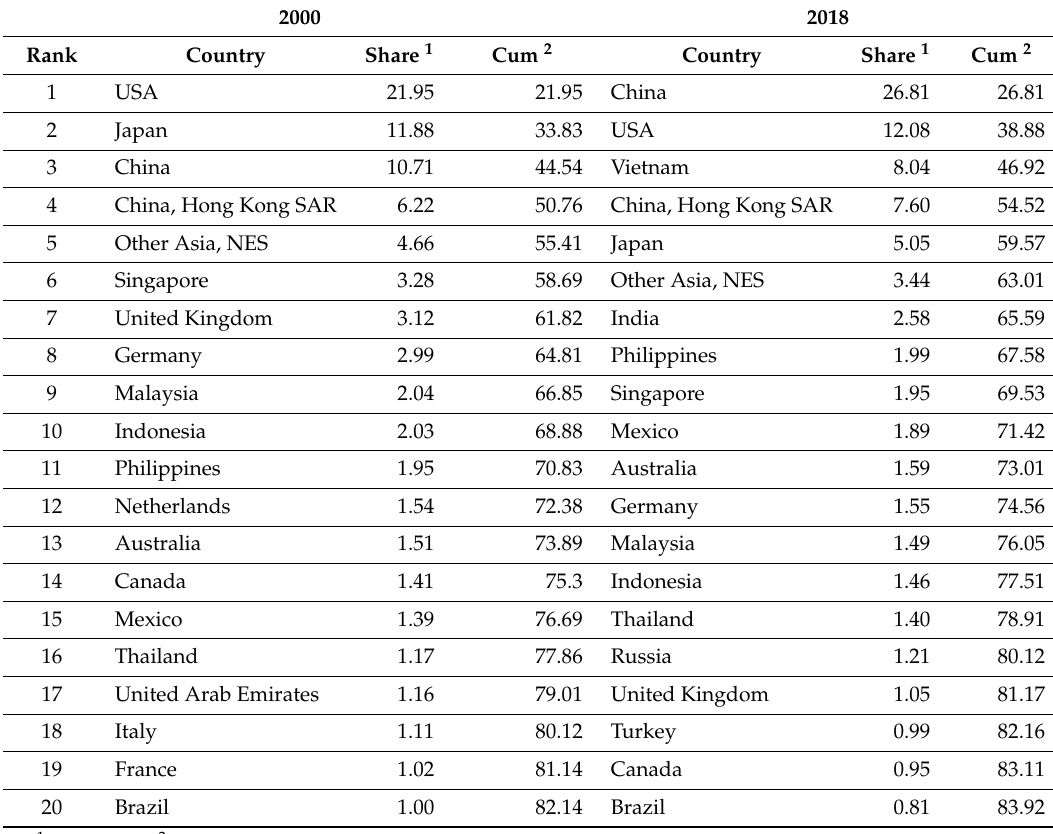
Table 7. Export Intensity Index: South Korea